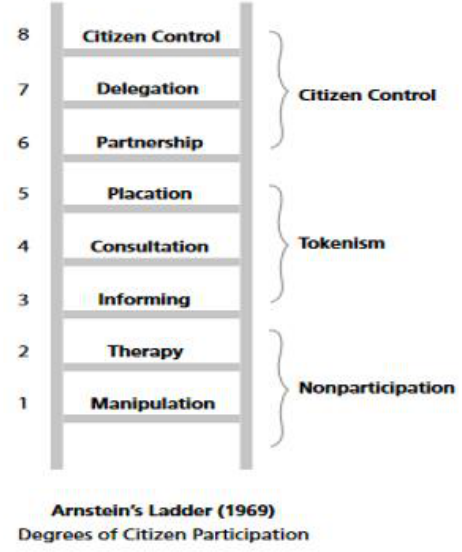
Figure 1: Ladder of Citizen Participation; Source: Arnstein